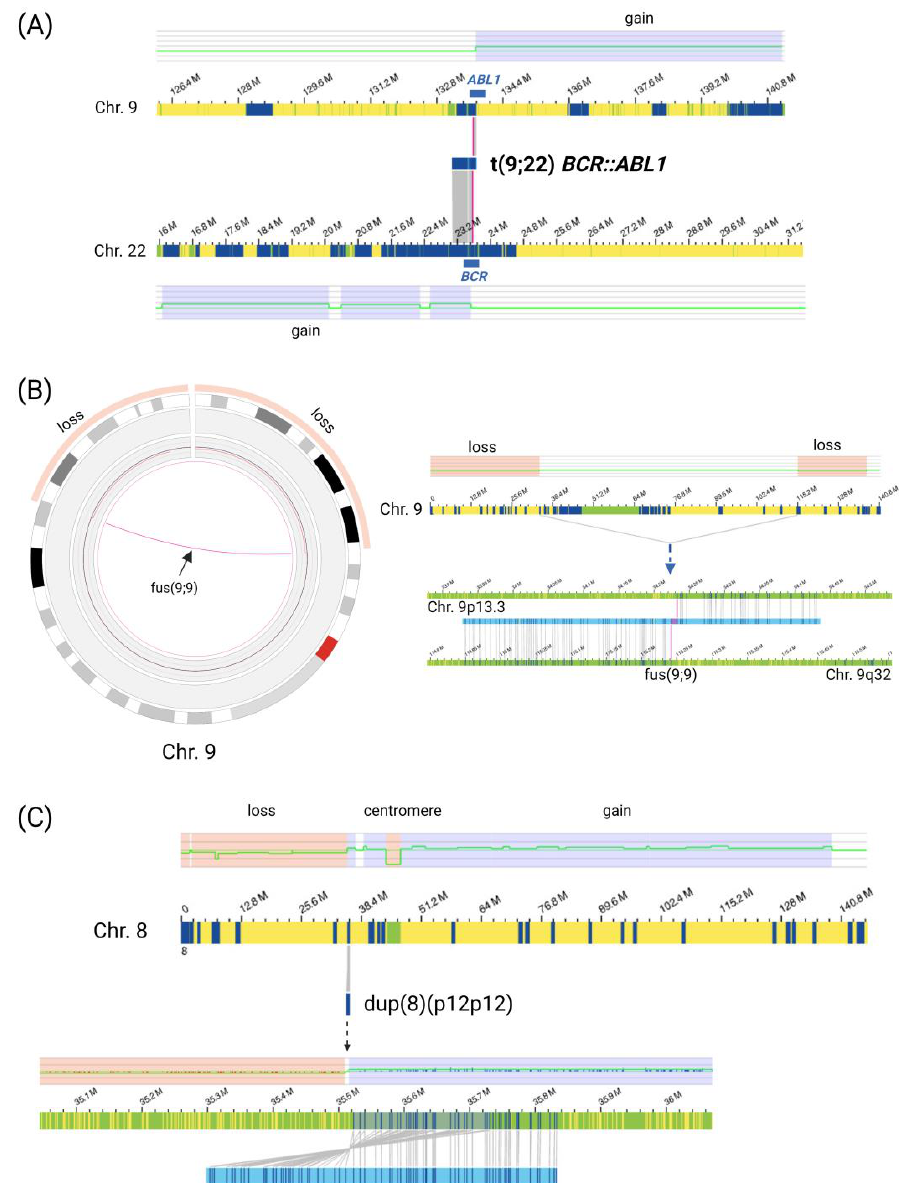
Figure 1. OGM detects different types of gross structural aberrations. ( A ) Additional Philadelphia- like chromosome in patient 2: visualized as interchromosomal translocation (9;22)(q34.12;q11.23) with BCR::ABL1 fusion in combination with neighboring copy number (CN) gains in close proximity to the translocation breakpoint region. CNV filter settings “no filter” were applied for visualization. ( B ) Presence of a ring chromosome of unknown origin previously detected by karyotyping could be confirmed and redefined by OGM to chromosome 9 material in patient 9. The ring chromosome presents as a translocation SV in combination with distal CN losses in circos plot and SV visualization. ( C ) Putative isodicentric chromosome idic(8q) presenting as CN gains on chromosome 8q and part of 8p in conjunction with an inverted duplication SV on 8p12 and a CN loss in close proximity (patient 4). CNV filter settings were set to “no filter” for visualization. Idic(8q) was not detected by karyotyping. Light blue and light red blocks depict gains and losses of chromosomal material in the respective regions. Blue blocks depict structural variants, green blocks depict masked regions including the centromeric region on chromosome depicted in yellow. Created with BioRender.com.